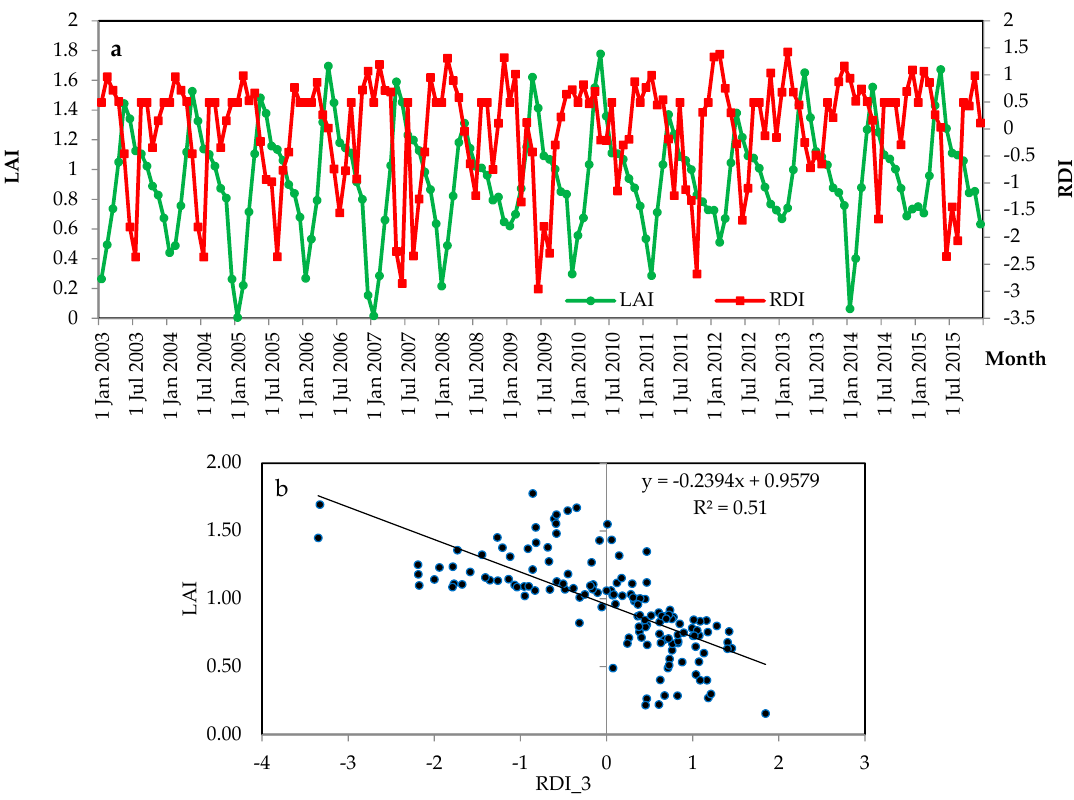
Figure 8. ( a ) RDI and LAI values for Behesht-Abad Basin (2003 to 2015), ( b ) Correlation coefficient between LAI and RDI with a 3-month lag time.